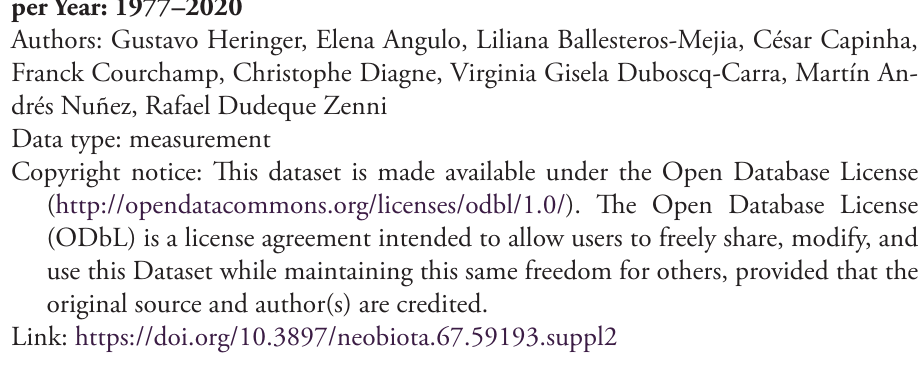
countries with costs reported per